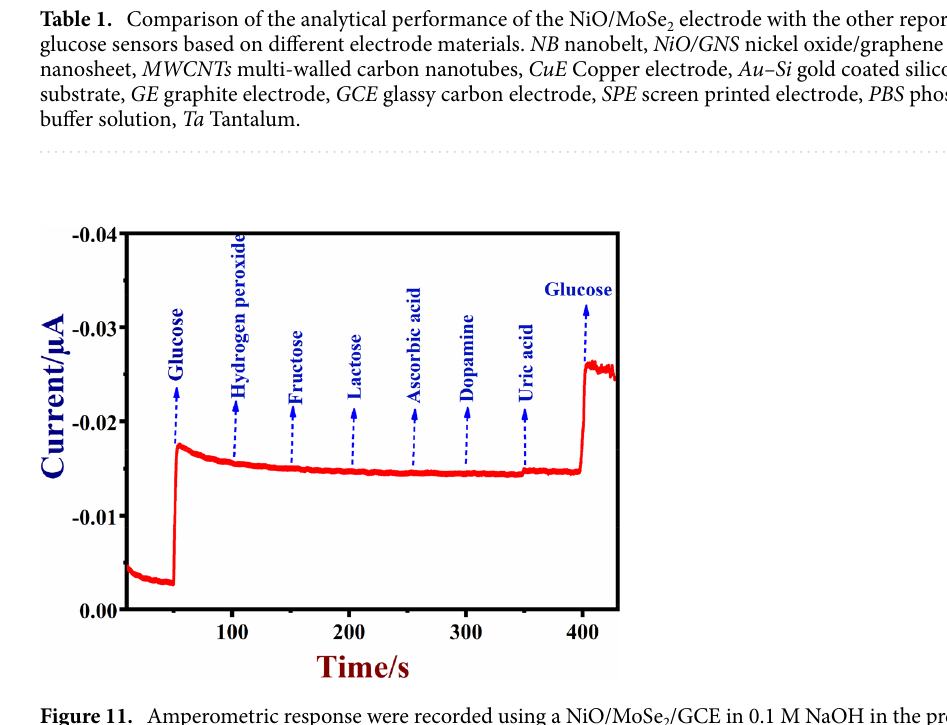
Figure 11. Amperometric response were recorded using a NiO/MoSe 2 /GCE in 0.1 M NaOH in the presence of H 2 O 2 (0.1 mM), fructose (0.1 mM), lactose (0.1 mM), ascorbic acid (0.1 mM), uric acid (0.1 mM), dopamine (0.1 mM) and glucose (0.5 mM). Rotation rate was 1200 rpm. The applied potential was 0.5